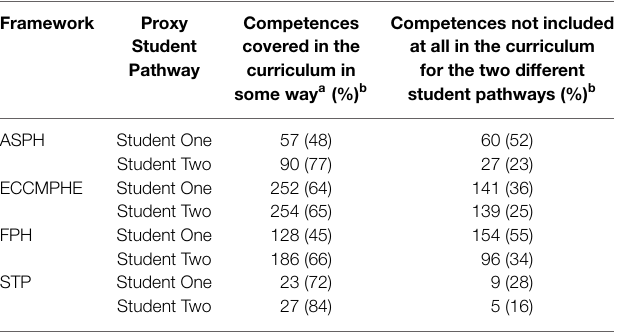
TABLE 4 | The number (%) of competences included in the curriculum for two proxy student pathways through the course .